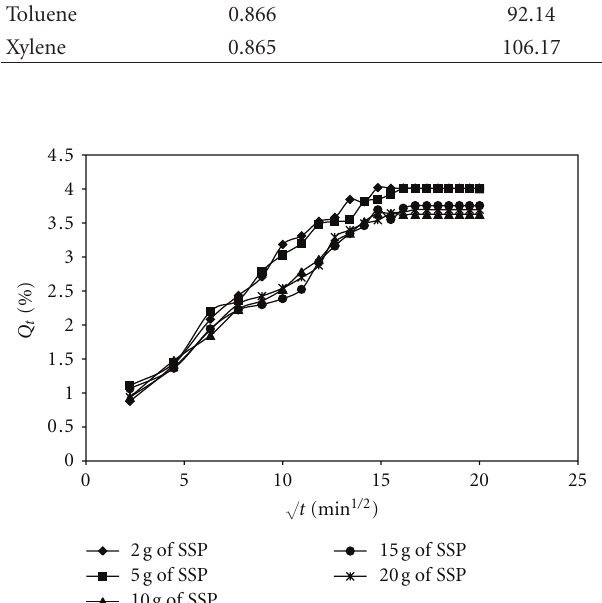
√ t (min 1 / 2 ) for snail shell powder